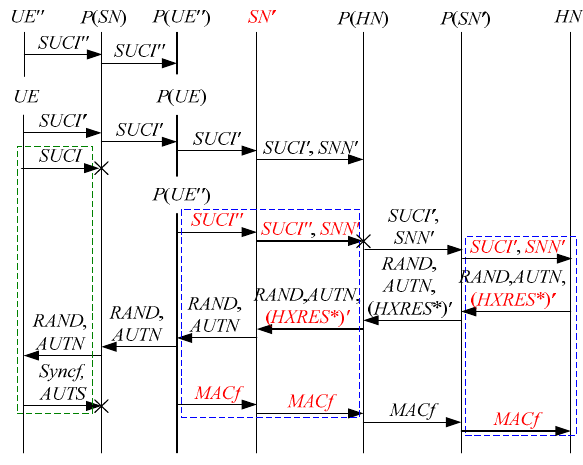
Figure 10. The ninth attack scenario of the 5G AKA protocol.